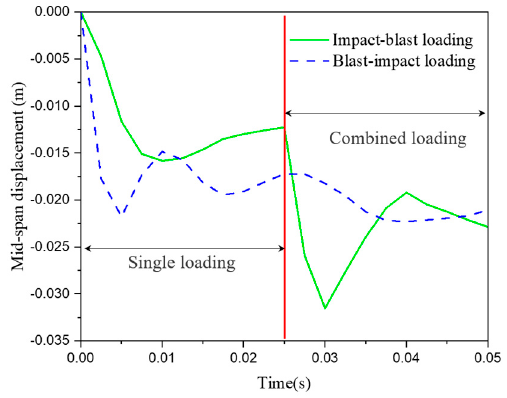
Figure 7. Damage states of the beam progressing under different combined loadings with V = 6.86 m/s and Z = 0.32 m/kg 1/3 .